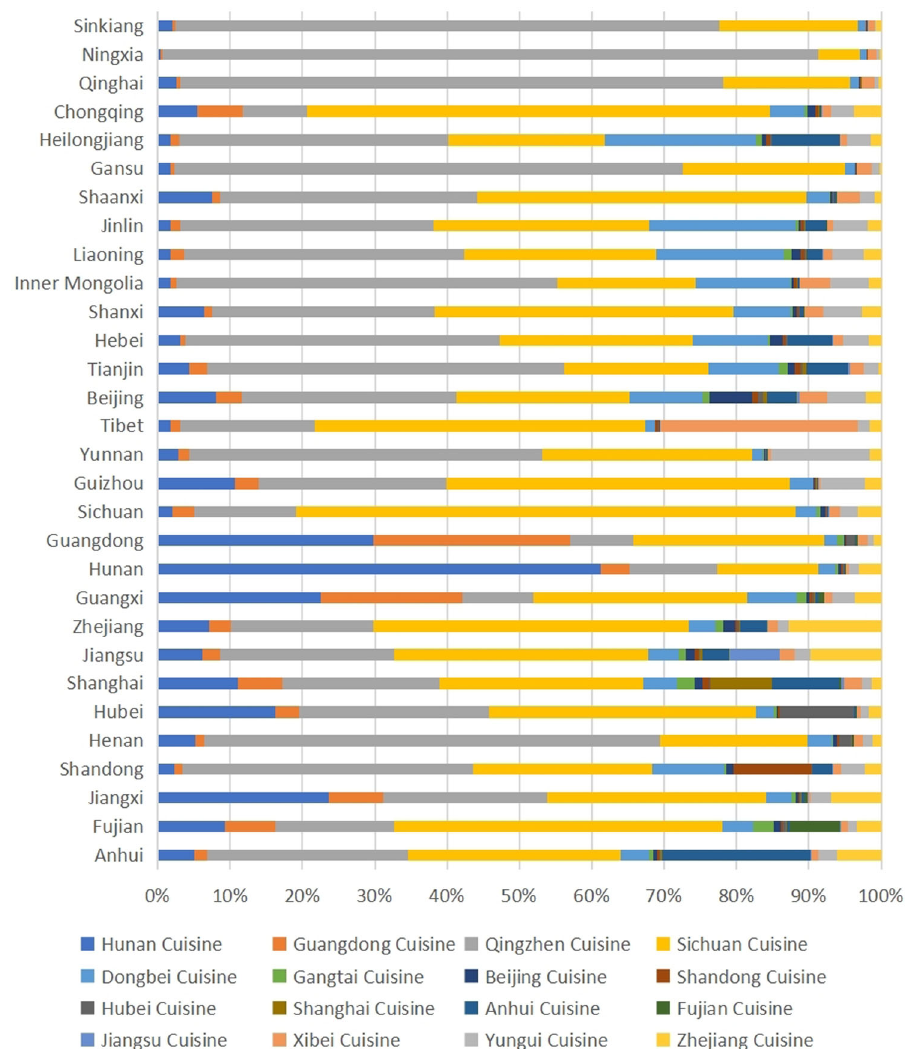
Fig. 1 Percentages of various types of PC in China ’ s provincial units. PC is the position of catering. Each PC has its own cuisine, our study excludes Taiwan, Macao, Hongkong &